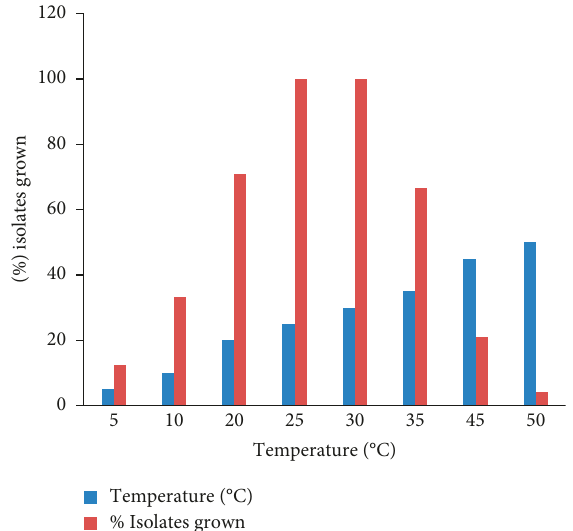
Figure 5: Tolerance of Mesorhizobium isolates to different pH